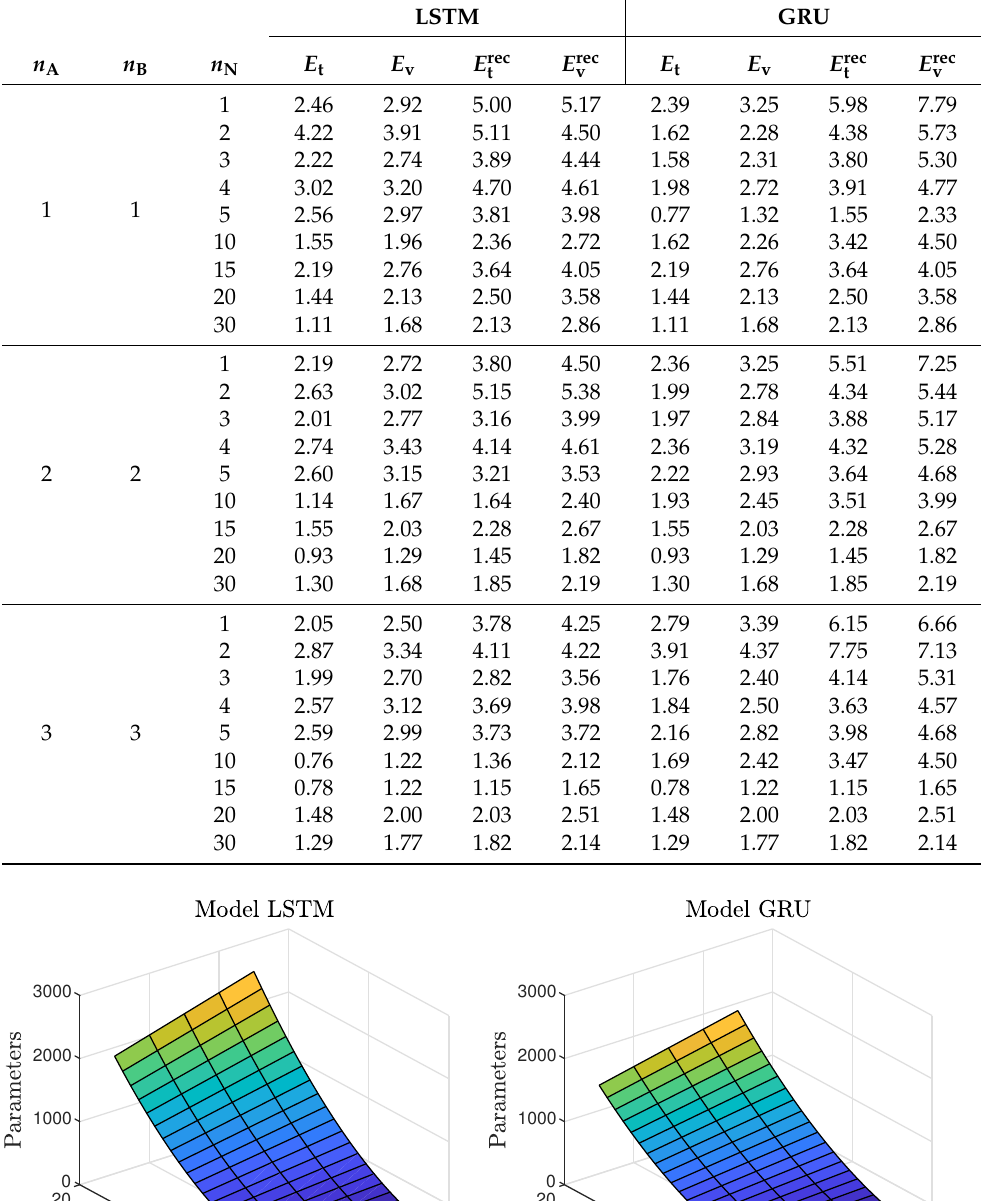
Table 4. The neutralisation reactor: comparison of selected LSTM and GRU networks with the recurrent inputs in terms of the training ( E t ) and validation errors ( E v ).